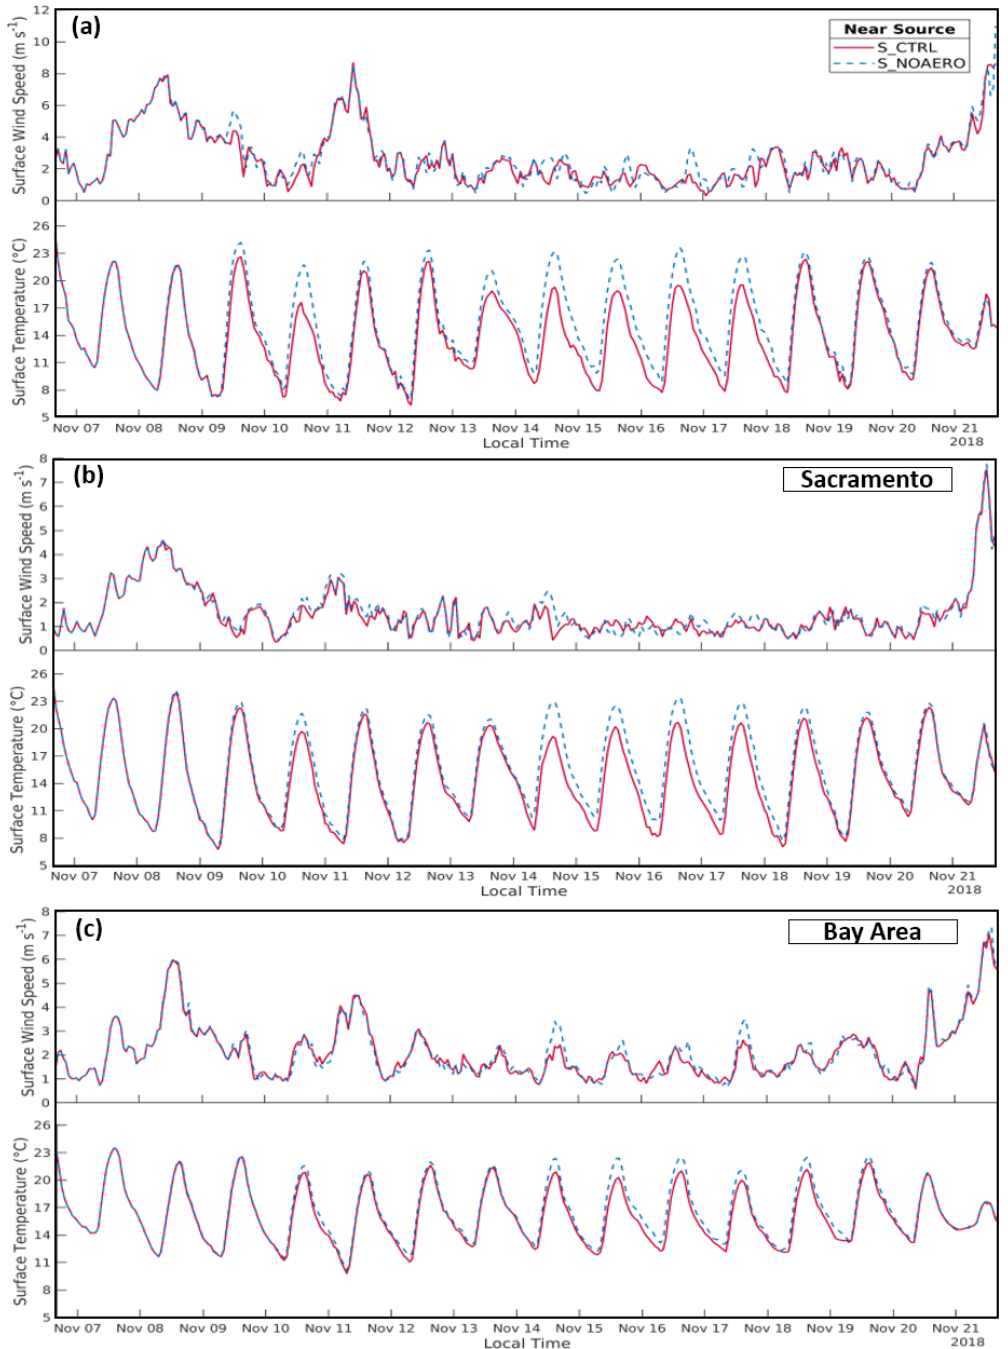
Figure 12. Comparison of meteorology generated by S_CTRL (solid red line) and S_NOAERO (in which aerosol effects do not feed back to the meteorology; dashed blue line) over the three areas of study: (a) near the wildfire, (b) Sacramento, and (c) the San Francisco Bay Area. Exclusion of the aerosol feedback has the greatest effect nearest the fire, where S_NOAERO increased wind and temperature by 9.8% and 9.7%, respectively, on average. The aerosol feedback mechanism has the least significance in the Bay Area, where S_NOAERO wind speed differs less than 2% and temperature differs 3.1% on average. The most pronounced changes occur during 14–16 November when S_CTRL significantly underpredicts surface PM 2 . 5 . In WRF-Chem, the feedback of aerosol–radiation interactions on meteorology acts to stabilize the atmosphere, slow wind speeds, and increase PM